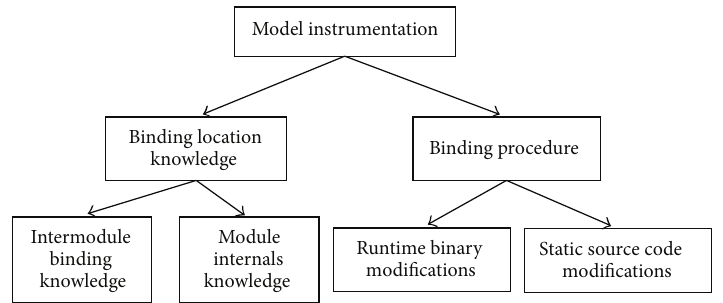
Figure 1: Instrumentation